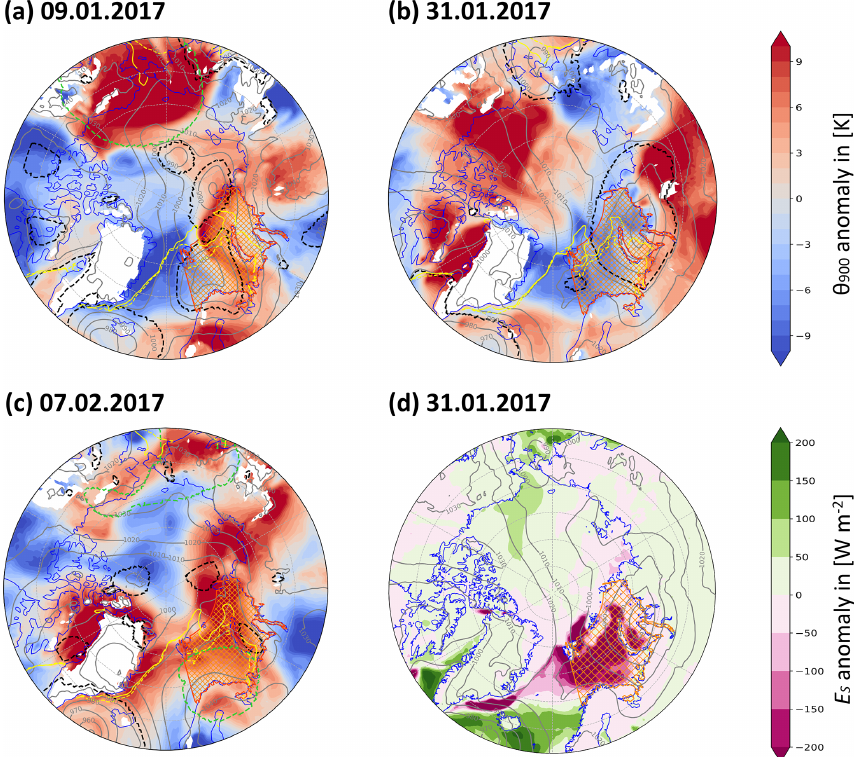
Figure 11. Synoptic situation on (a) 9 January 2017 (day 40), (b) 31 January 2017 (day 62) and (c) 7 February 2017 (day 69). Daily anomaly of potential temperature at 900hPa ( θ 900 ; K, color). Sea ice edge (SIC = 0.5, solid yellow line), climatological sea ice edge (SIC clim = 0.5, dashed yellow line), cyclone mask (dashed black contour) and blocking mask (dashed green contour) at 00:00UTC on the considered days. Daily E S anomaly ( E S ∗ ; Wm − 2 , color) on 31 January 2017 (day 62) is shown in panel (d) . Sea level pressure (SLP) is shown by grey contours in intervals of 10hPa. The region of the Kara and Barents seas is marked by orange